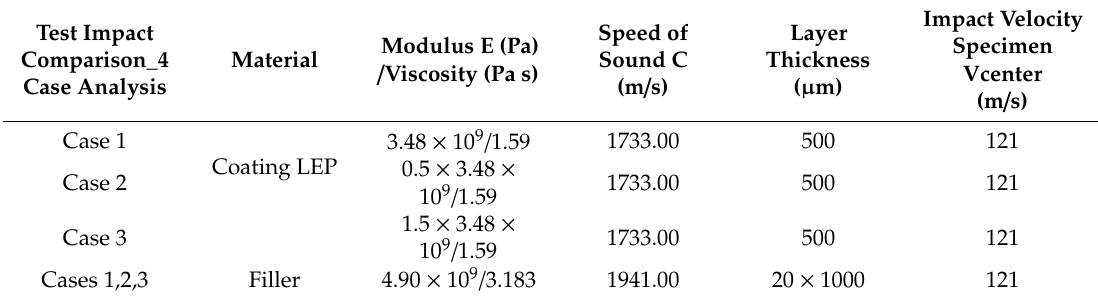
Table 4. Modelling input data for variation cases in coating modulus (stiffness) and considering semi- . infinite substrates, h (cid:2929) > 2d (cid:2887) (cid:3177) (cid:2887) (cid:3144)